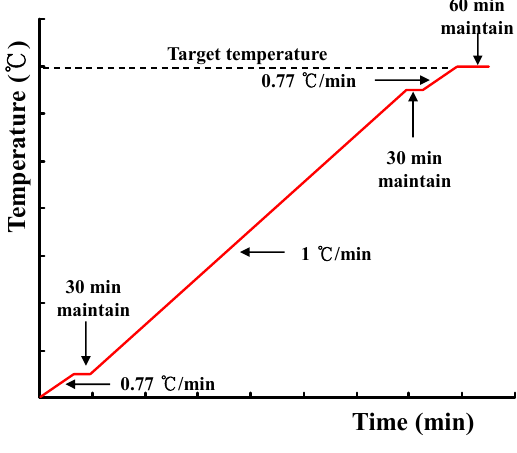
Figure 3. Heating curve used in the experiment.